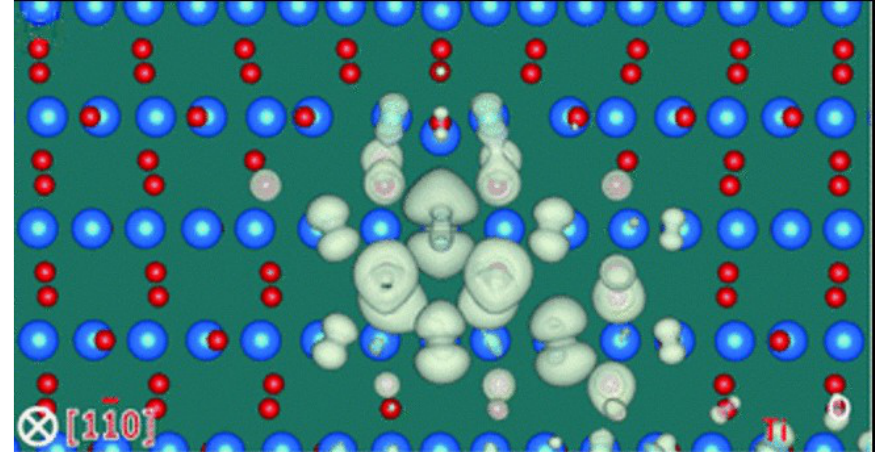
Figure 33. Charge density distribution at the edge dislocation in TiO 2 with b = 1 ⁄ 4 [001] viewed from the [110] projection. From the (grey) isosurfaces it can be seen that the charge induced by the local non-stoichiometry remains rather localized around the core. Adapted from